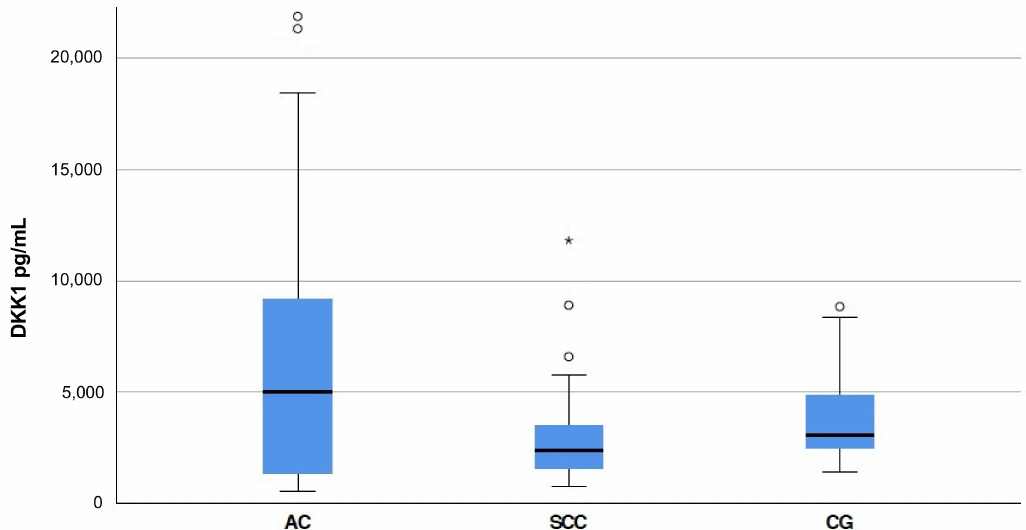
Figure 1. S-DKK1 levels in the esophageal cancer study cohort analyzed. Boxplot of S-DKK1 levels in esophageal cancer patients with standard deviation determined by ELISA. The esophageal adenocarcinoma (AC) group consists of 61 patients, the esophageal squamous cell carcinoma (SCC) patients’ group and the healthy control (CG) consist of 30 patients each. Extreme values were marked in the Figure and encoded as following: °, > 1.5 box lengths from one hinge of the box; *, > 3 box lengths from a hinge of the box. Each symbol represents the S-DKK1 level of one